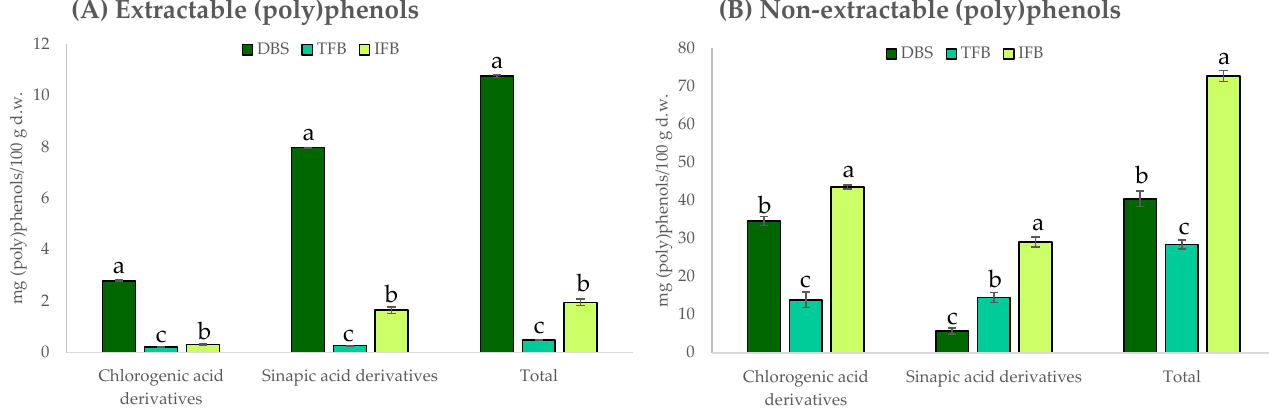
Figure 1. Contents of individual (poly)phenols (chlorogenic acid derivatives and sinapic acid derivatives) and the total contents of (poly)phenols determined as the sum of the individual compounds (mg/100 g d.w.): ( A ) extractable phenolics (EPP) and ( B ) non-extractable phenolics (NEPP), analysed by HPLC-DAD for freeze-dried broccoli stalk ( ■ DBS), the total fibre fraction ( ■ TF B ) and the insoluble fibre fraction ( ■ IF B ). Values are expressed as mean ± SD (n = 3). Different letters (a–c) indicate significant differences among the samples ( p < 0.05) for each individual group and the total (poly)phenols.